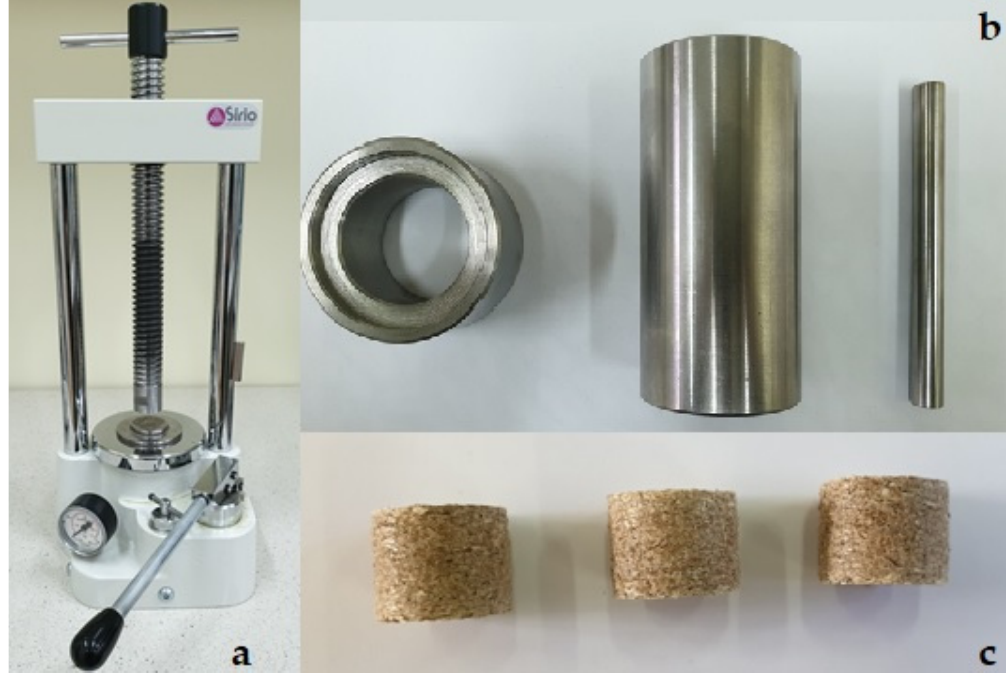
Figure 2. Compaction station: ( a ) hydraulic press SIRIO P400, ( b ) compaction chamber and piston, ( c ) samples.